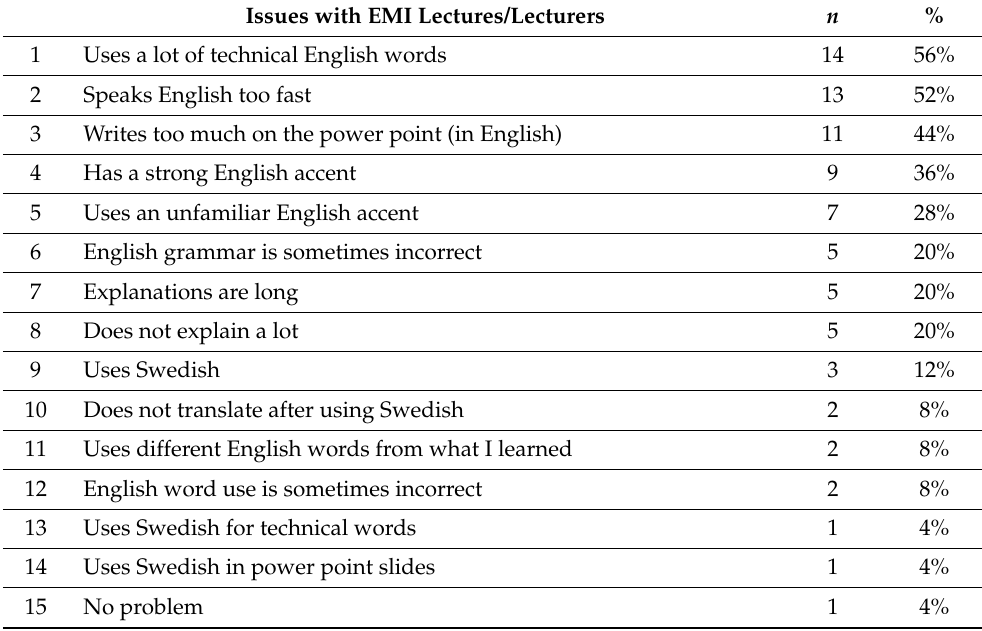
Table 2. Language issues in Swedish EMI